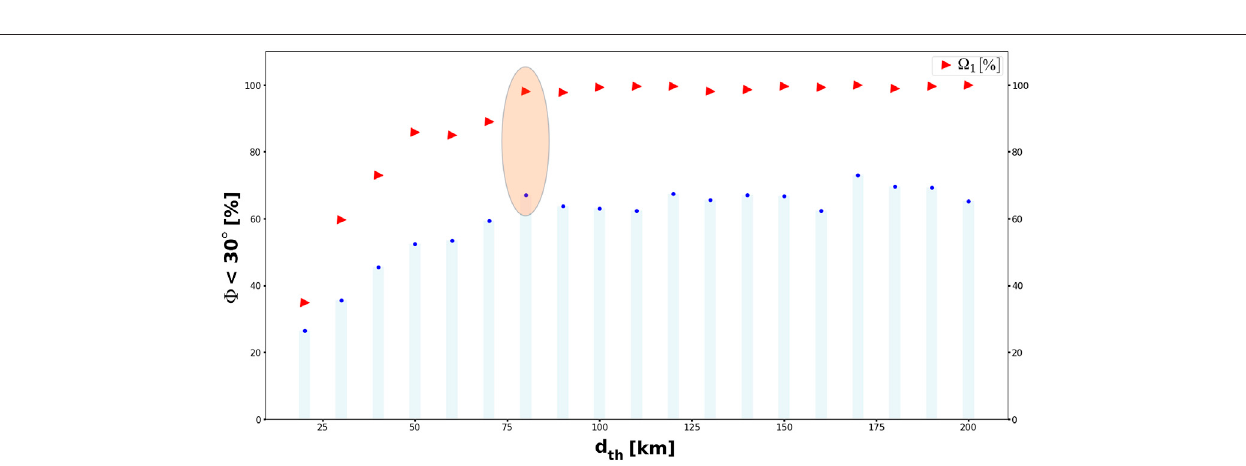
Frontiers in Earth Science |